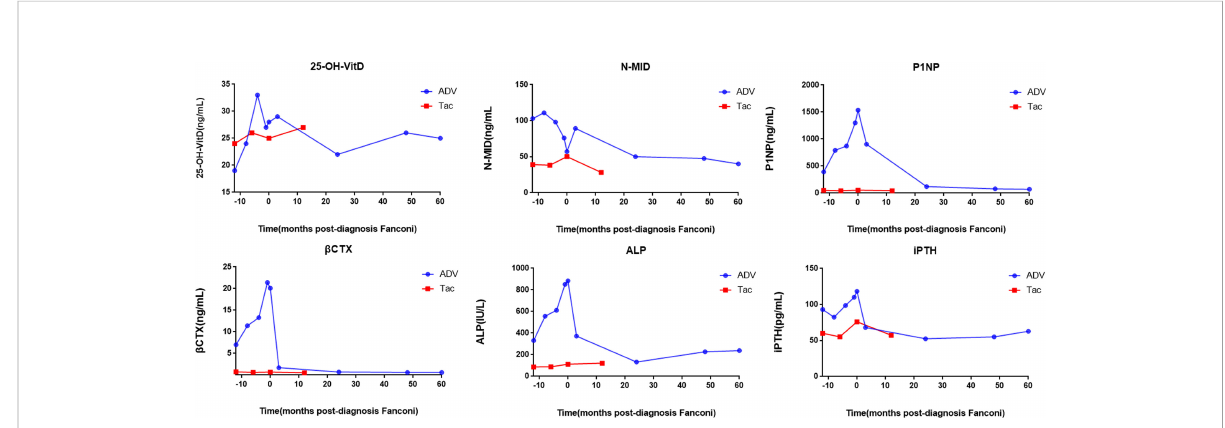
FIGURE 4 Changes of bone metabolism index before and after diagnosis of Fanconi syndrome. 25-OH-VitD, 25 hydroxyVitamin D; N-MID, N-terminal mid-fragment; P1NP, procollagen type 1 N-terminal peptide; b CTX, b -isomerized cross-liked C-telopeptide of type 1 collagen; ALP, alkaline phosphatase; iPTH, intact parathormone.